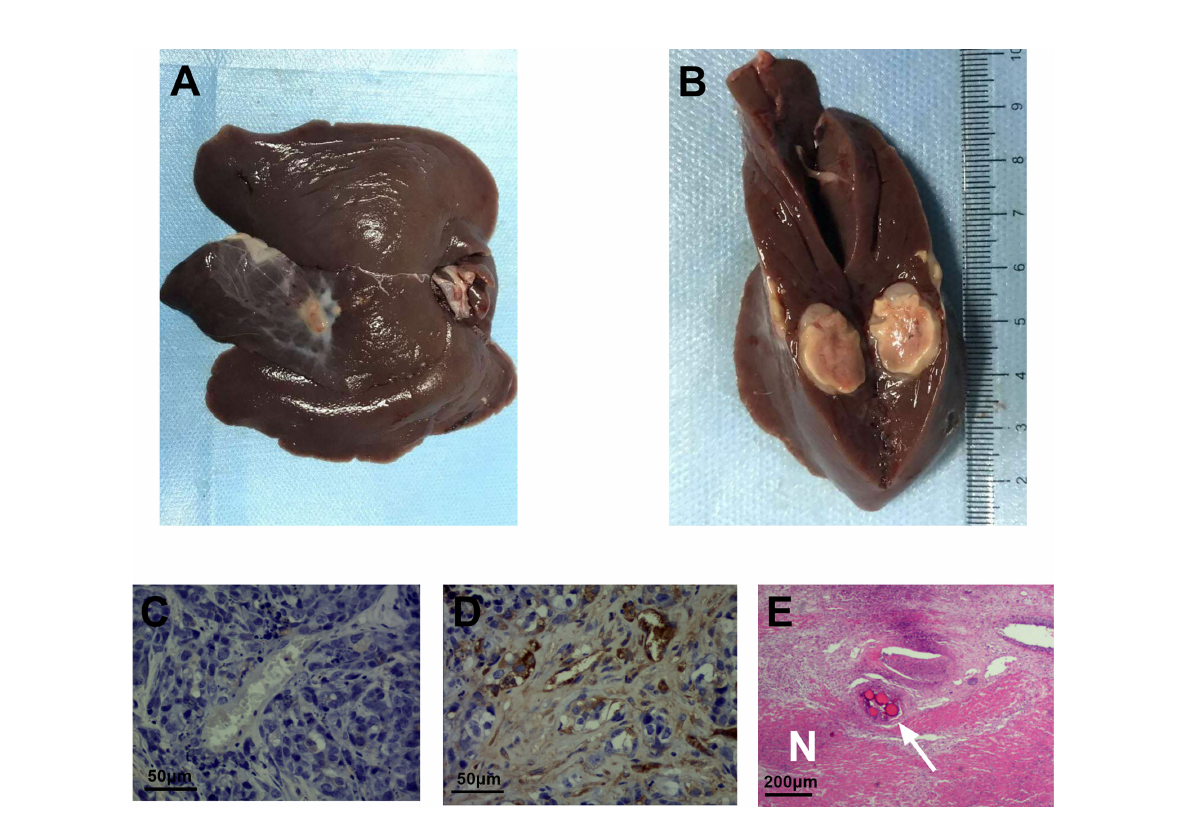
FIGURE 6 CD34 immunohistochemical staining and HE staining of the experimental and control groups. (A) pathological tissues from the experimental group. (B) coagulative necrosis was present in the center of the tumor, a fi sh- fl esh appearance at the edge of the tumor. (C) CD34 immunohistochemical staining of the experimental group showed a few scattered brownish-yellow cells(400 times). (D) CD34 immunohistochemical staining of the control group still exhibited a large number of brownish-yellow cells(400 times). (E) the necrotic area (N) and embolization of microspheres in blood vessels (arrow) can be visualized by HE staining of the experimental group(100